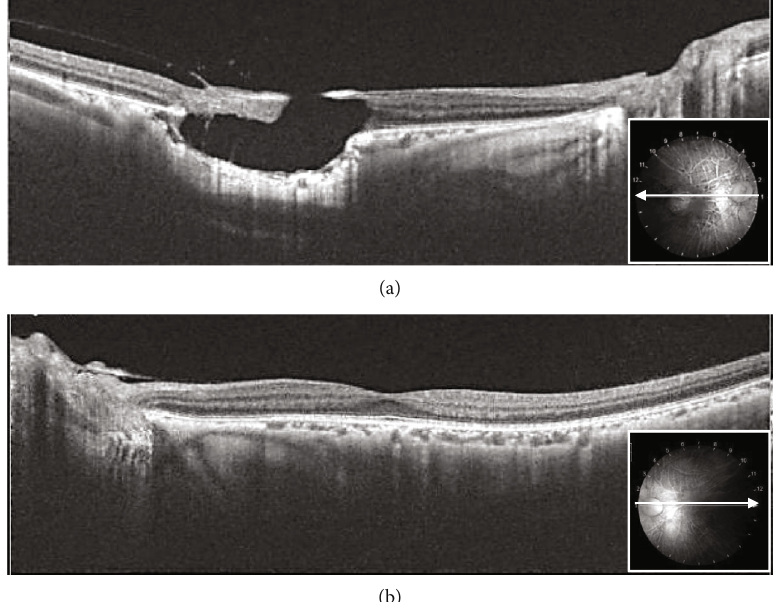
Figure 6: Right (a) and left (b) optical coherence tomography images. Note a full-thickness macular hole with underlying choroidal excavation in the right